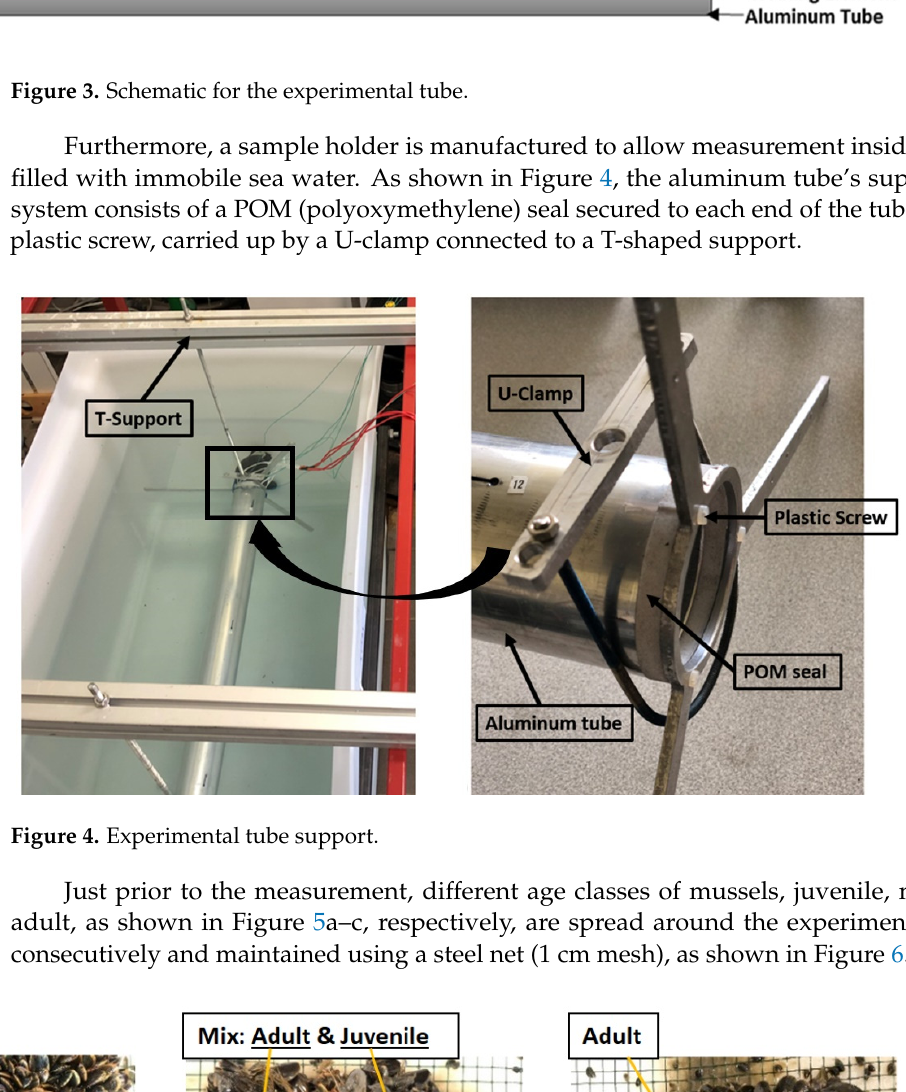
Figure 3. Schematic for the experimental tube.